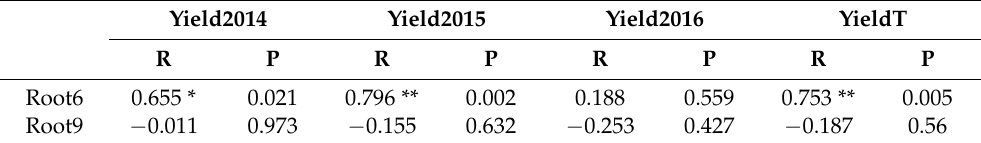
Table 4. Relationships between above-ground net primary production and below-ground net primary